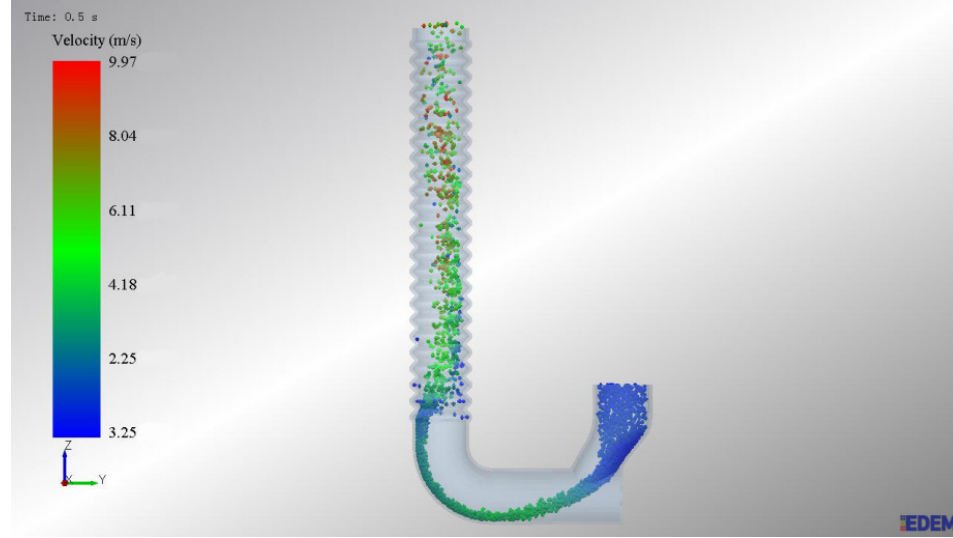
Figure 6. Particle velocity profile.